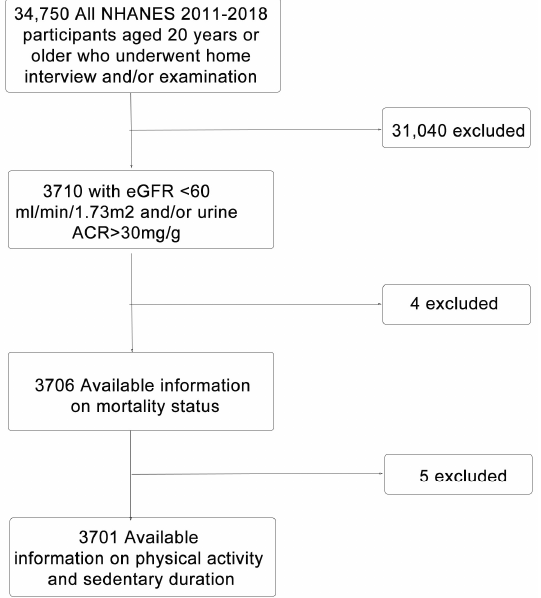
Figure 1. Flowchart of cumulative study participant exclusions.